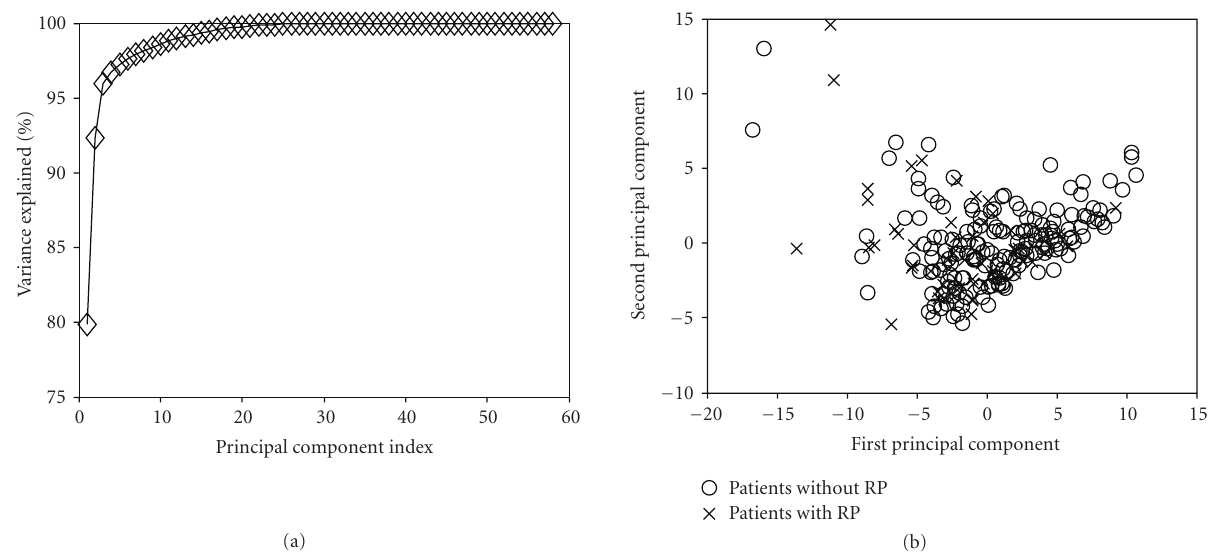
Figure 8: Visualization of the 58 variables related to RP by PCA. (a) Variation explanation versus principle component (PC) index. This represents the variance of the data model about the mean prognostic input factor values. (b) Data projection into the first two components space. Note the high overlap in projection space, which suggests nonlinear kernel modeling to achieve better predictive